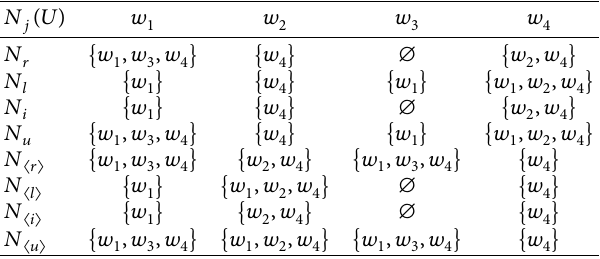
Table 1: N j -neighborhoods of each element in